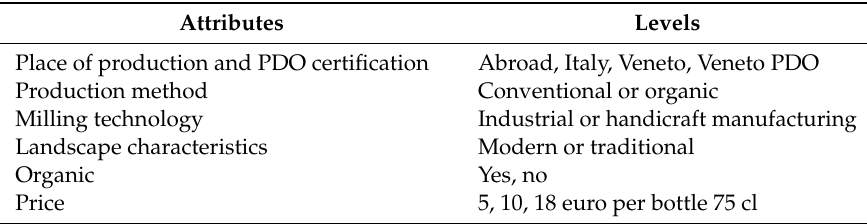
Table 1. Attributes and levels considered in the choice